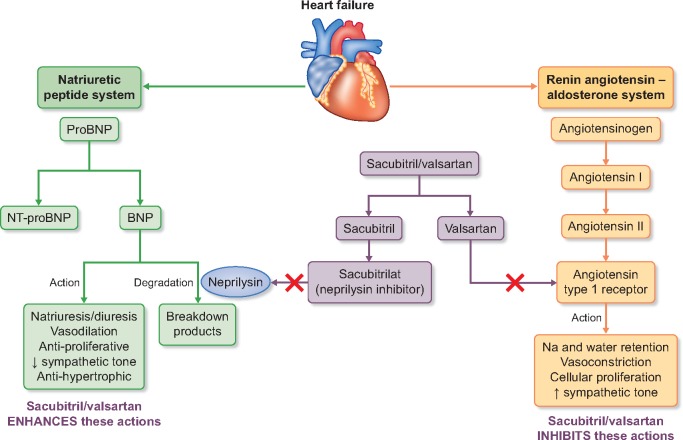
Effects of sacubitril/valsartan on vasoactive peptides.